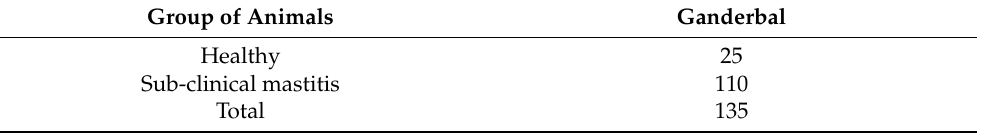
Table 8. Sample collection from Ganderbal district in the state of Jammu and